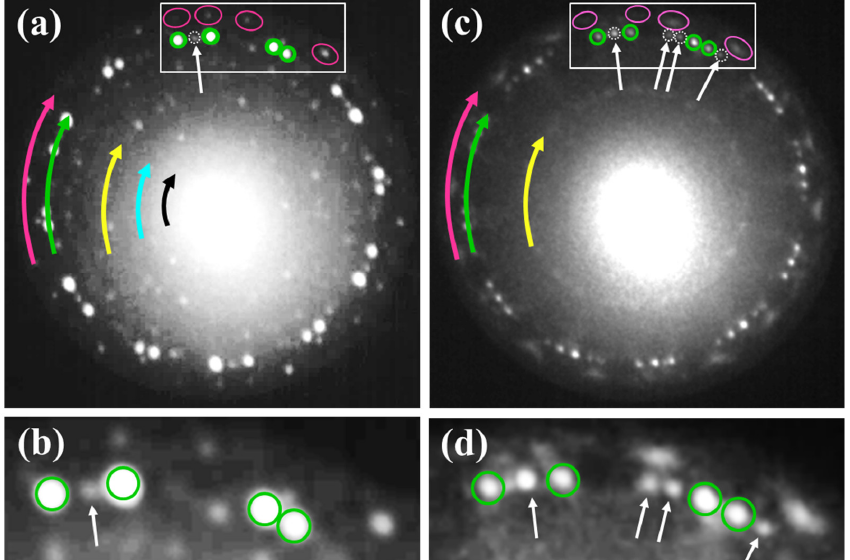
Figure 4. LEED pattern with fingerprint of well-ordered planar phase of silicene (ring marked by green arrow), recorded at 475 K ( a ). Twenty-four spots with strong intensity correspond to 4 major domains—four are marked by green circles. Barely visible additional domain is marked by white dashed circle. Almost invisible outer ring consisting of diffraction spots related to low buckled silicene is marked by pink arrow. Four selected spots representing four domains of low buckled silicene are marked by pink loops. Diffraction spots forming three inner rings correspond to (√3 × √3) (yellow), (√7 × √7) (cyan) and (√21 × √21) (black) superstructures. ( c ) LEED pattern of silicene recorded at 500 K. Additional diffraction spots indicated by white arrows appear. Enlarged region of diffraction pattern registered at 475 K ( b ) and 500 K ( d ). LEED patterns taken at E = 14.2 eV.